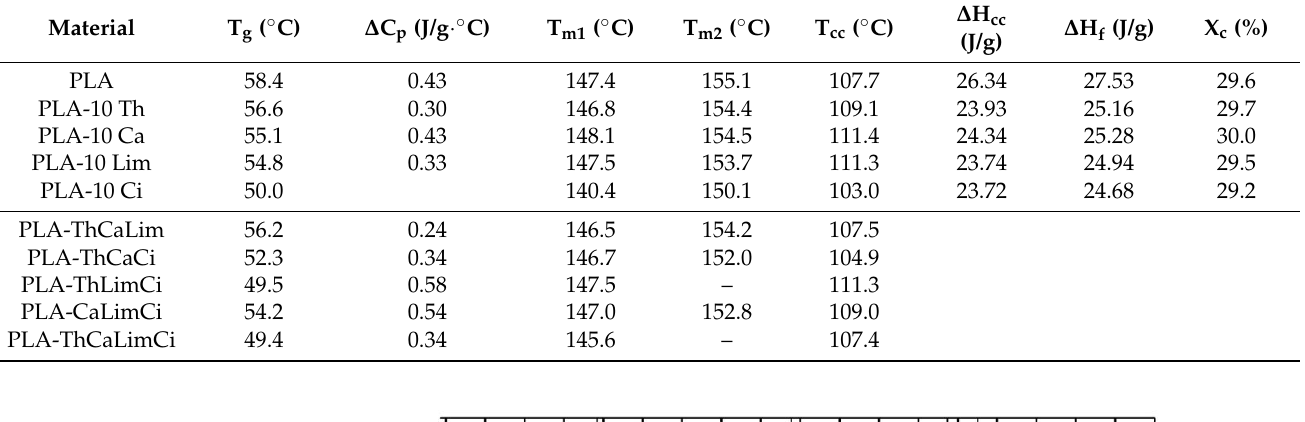
Table 3. Thermal transitions, melting enthalpy and degree of crystallinity of PLA, and all composite films obtained by solution casting.